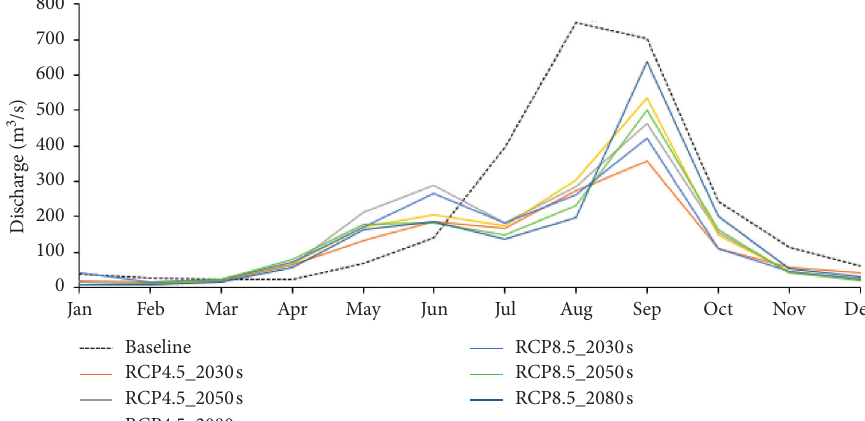
Figure 7: Ensemble mean monthly discharges under RCP4.5 and